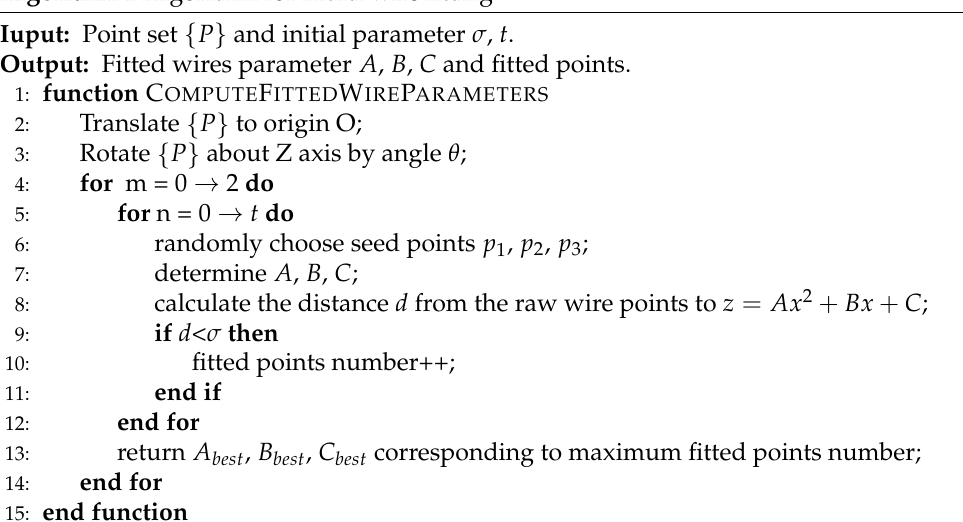
Figure 11. Transformation procedures of the point set { P } in the XOY plane. Algorithm 1 Algorithm for multi-wire